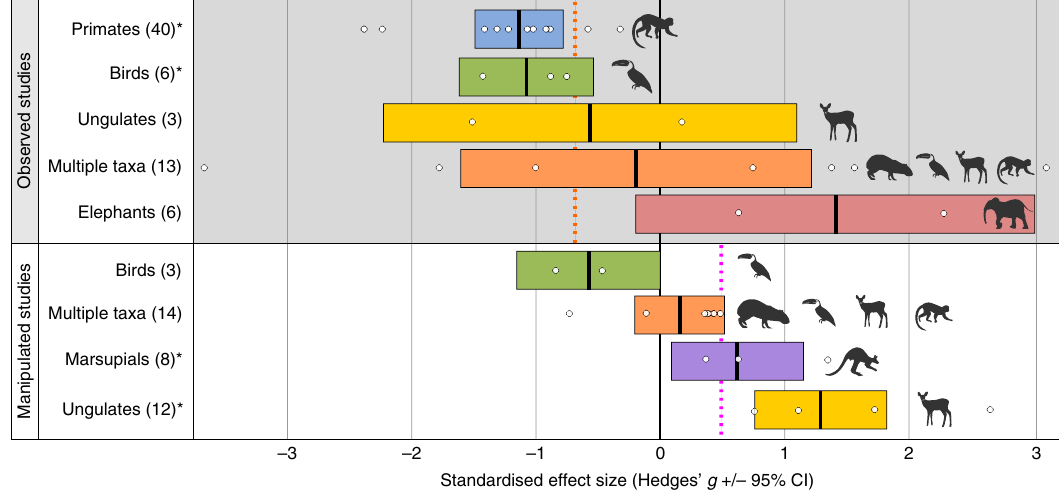
Fig. 2 Effect sizes of defaunation on forest regeneration by taxonomic group category. Observed and manipulated studies are analysed separately. The number of pairwise comparisons between high fauna and low fauna treatments per category is reported in parentheses, mean standardised effect size (Hedges ’ g ) is indicated by the bold vertical line in the centre of the coloured box, and 95% con fi dence intervals are represented by the width of the coloured box. Asterisks (*) denote categories where the con fi dence intervals do not overlap zero, indicating a signi fi cant effect (Hedges ’ g ). Please note that the fi gure shows the impact related to the absence of each taxonomic group category; a negative effect size means that defaunation is having a detrimental impact on forest regeneration. Vertical dashed lines show the mean overall effect size for observed ( − 0.68) and manipulated ( + 0.45) studies,